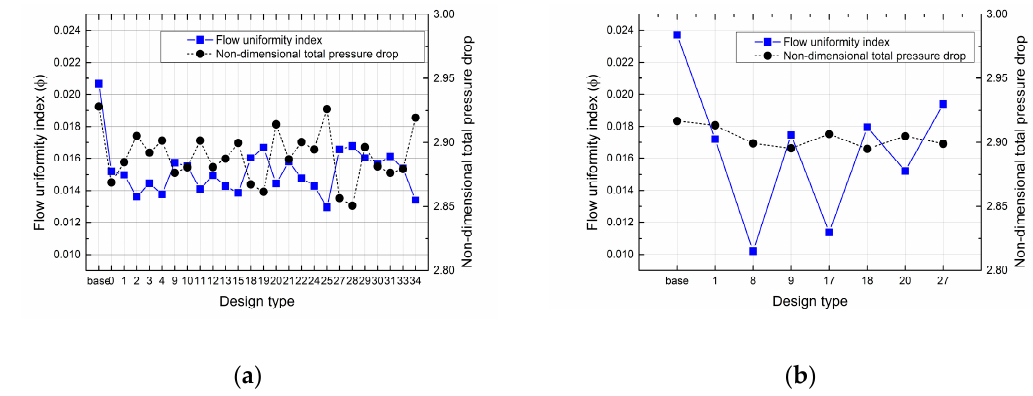
Figure 13. Comparison of flow characteristics between the base model and novel designs: ( a ) U-type; ( b ) Z-type.